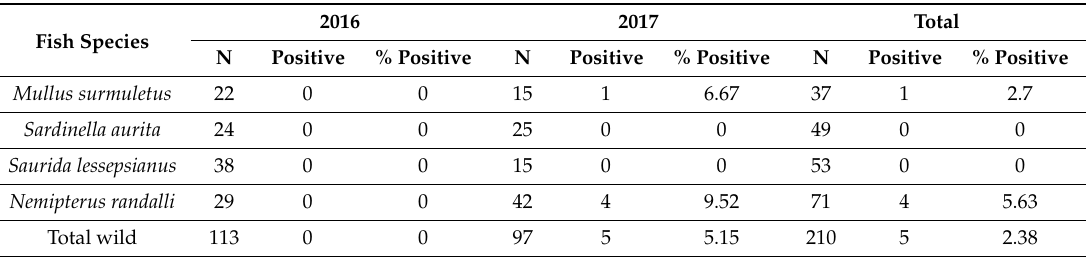
Table 7. Mycobacterium prevalence in wild fish species from the Mediterranean Sea. The results are based on PCR targeting 16S rRNA